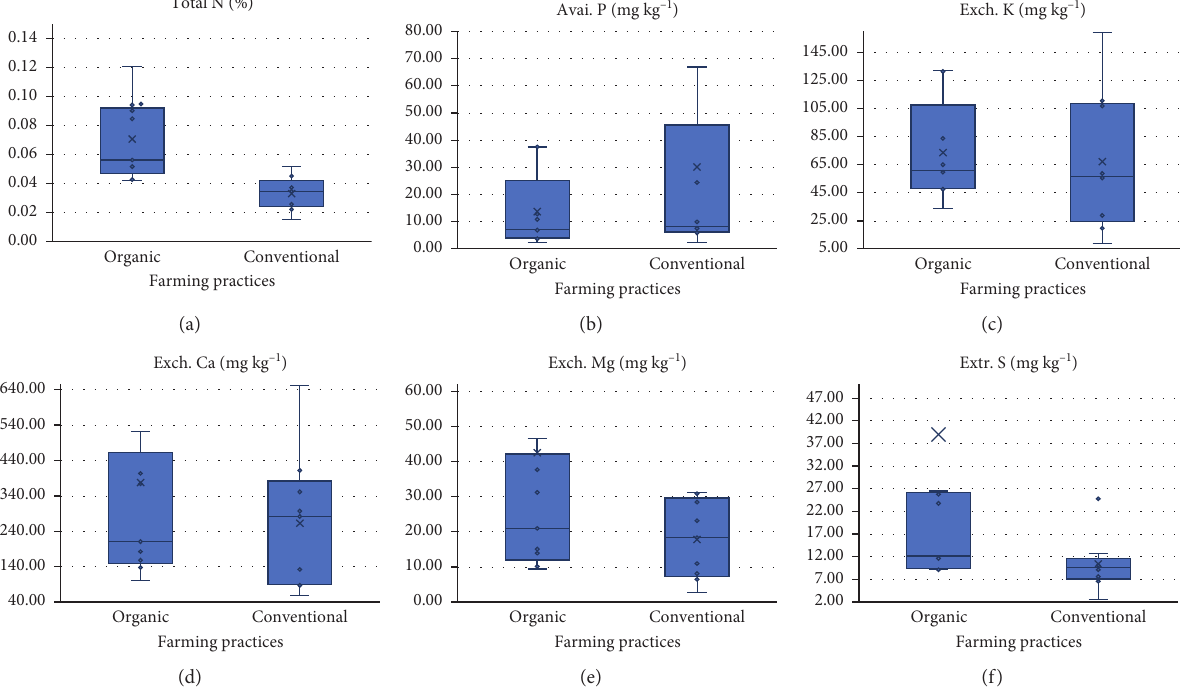
Figure 6: Soil mineral concentration (a–f) in soils collected from organic and conventional farming (ORF and CRF, respectively) systems. The error bars represent the standard deviation of measurements for nine soil